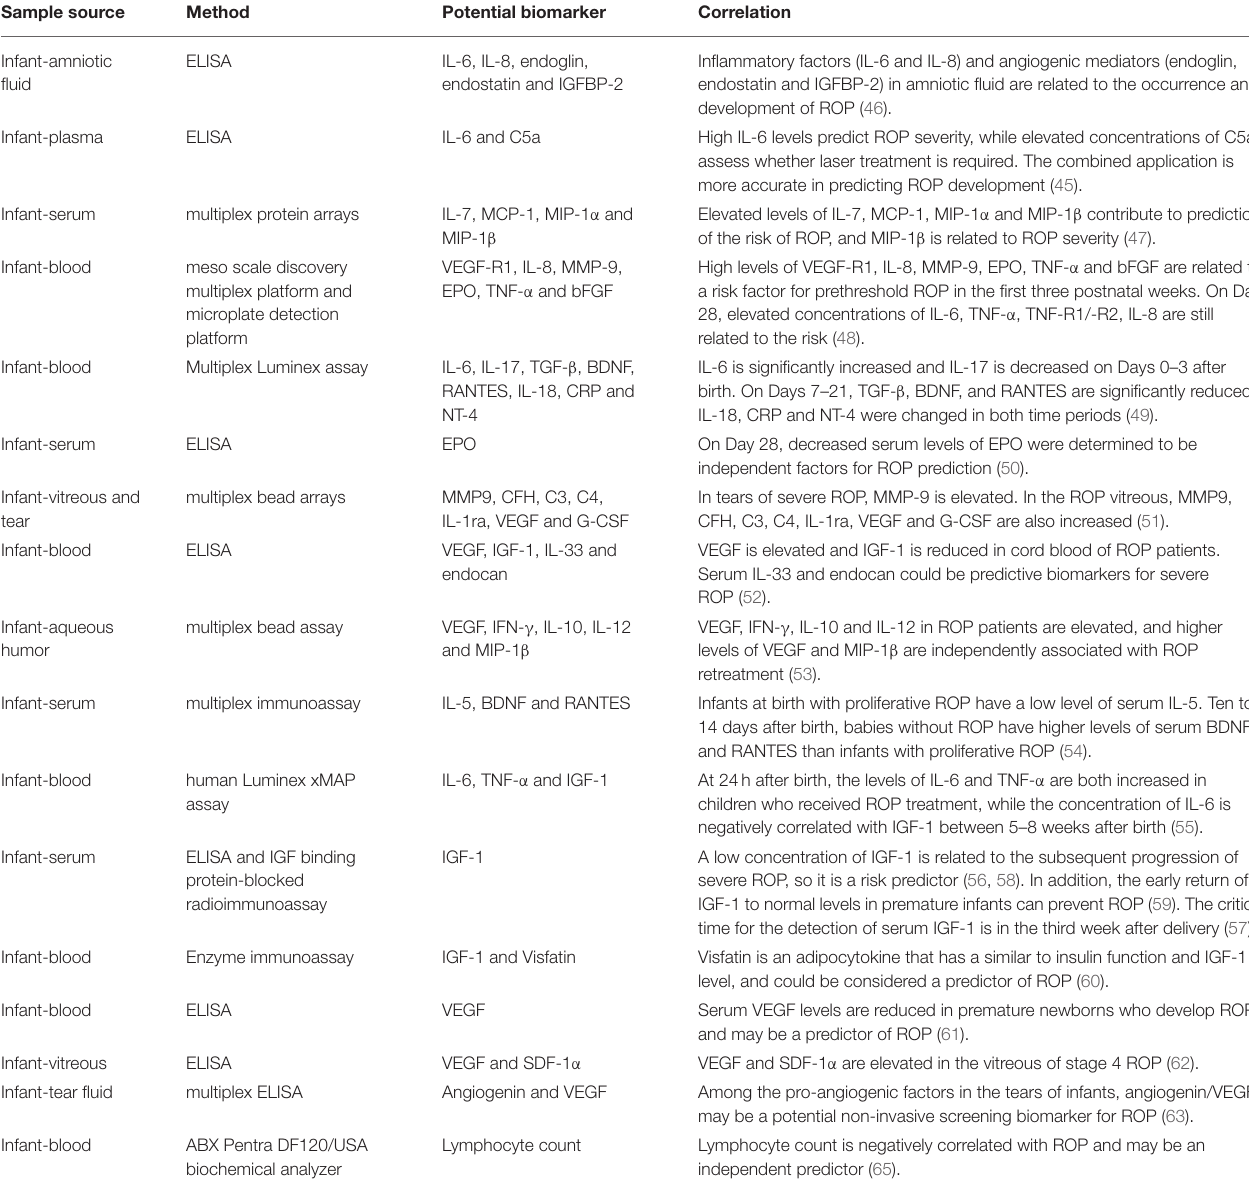
TABLE 2 | Cytokines and growth factors as potential biomarkers for ROP